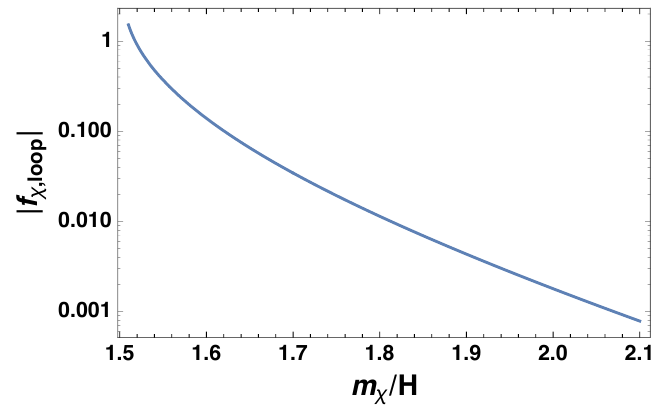
Figure 5 . The strength of NG for loop level scalar exchange as a function of scalar mass m (cid:31) for (cid:3) (cid:27) = 4 H and _ (cid:27) 0 = (cid:0) H 2 . The function j f (cid:31); loop ( (cid:22) ) j is de(cid:12)ned in eq. (5.20). where F is de(cid:12)ned in eq. (A.4) and (cid:22) = j f ( (cid:22) ) j as a function of the scalar mass, m (cid:31); loop